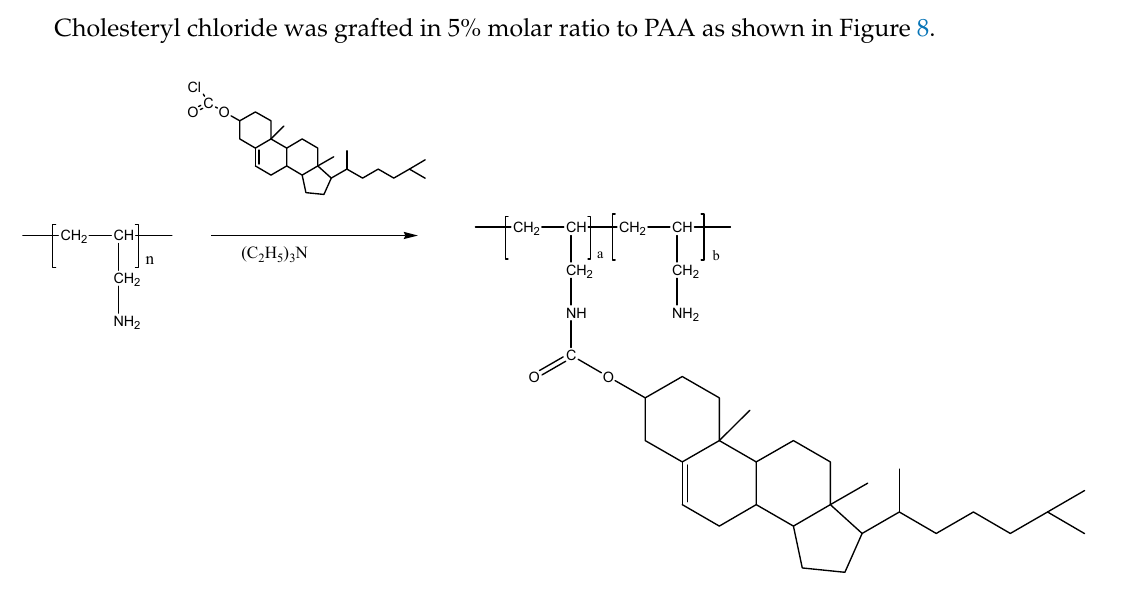
Figure 8. Chemical synthesis of cholesterol-PAA ( Ch5 ).